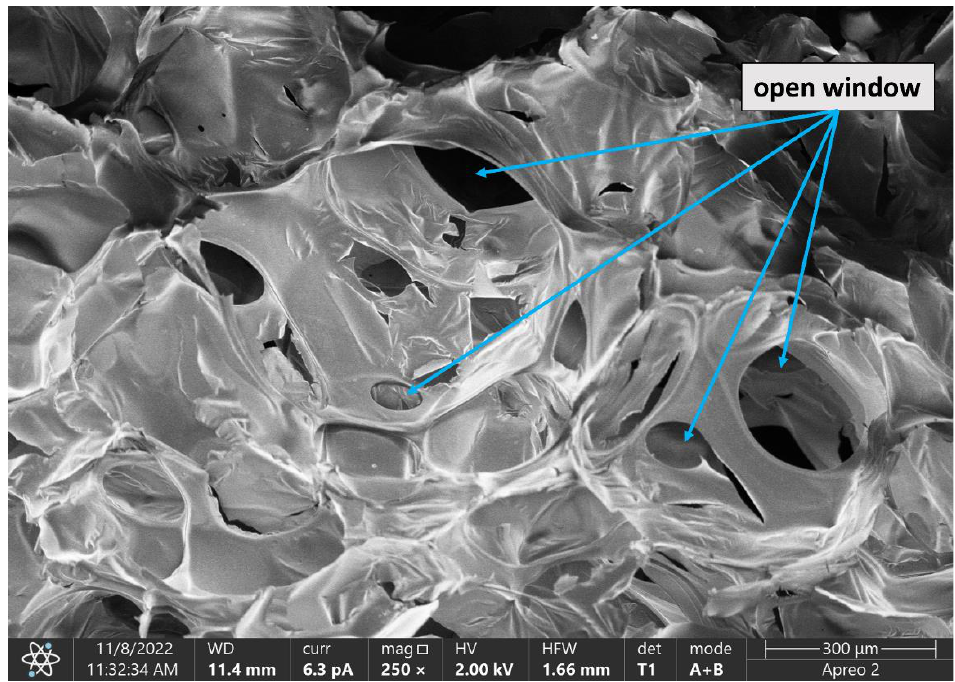
Figure 9. SEM image of the F_OR foam at a magnification of 250× with the open cells marked.